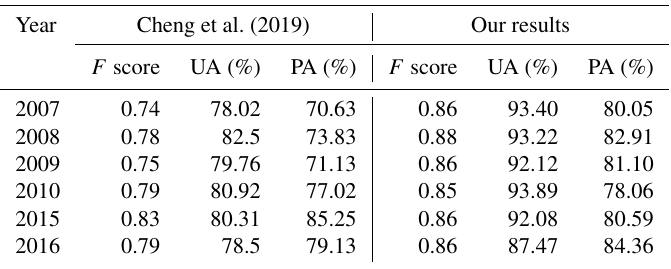
Figure 5. Comparison of the annual oil palm plantation area among FAO and USDA statistics, MPOB records for Malaysia, BPS-Statistics and oil palm concessions from GFW for Indonesia and our mapping results in (a) Malaysia, (b) Indonesia, and (c) Malaysia and Indonesia from 2001 to 2016. The blue lines represent the gross gain (unidirectional expansion), while the green lines show the net changes of oil palm from 2007 to 2016. The shaded area within the two boundary lines is the uncertainty range of the oil palm area. The upper boundary lines represent the upper limit area of oil palm within the two periods (2011–2014 and 2001–2006), whereas the lower boundary lines are the lower limit according to our results. Note that during the gap between the two periods, no uncertainty could be derived, which does not mean that the uncertainty was small. Table 3. The comparison of the oil palm accuracy between our mapping results and Cheng et al. (2019) for the 6 mapping years in Malaysia. UA: user’s accuracy. PA: producer’s accuracy.